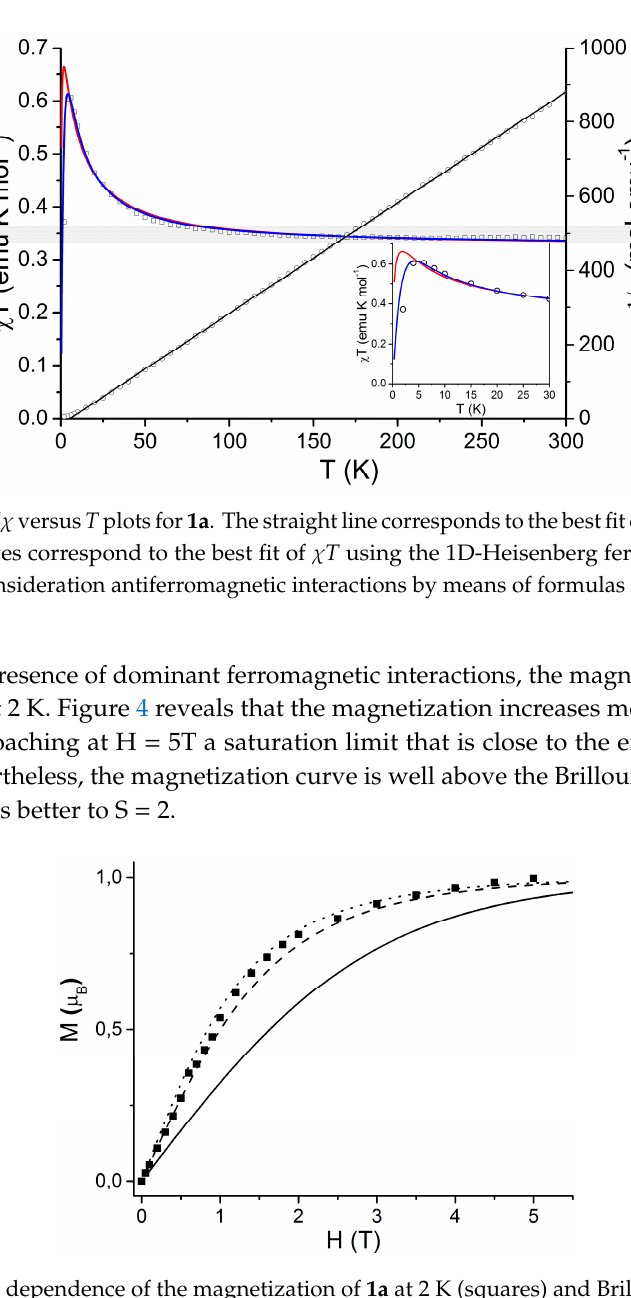
Figure 4. The field dependence of the magnetization of 1a at 2 K (squares) and Brillouin functions for S = 1/2 (solid curve), S =3/2 (dashed curve), and S = 2 (dotted curve).